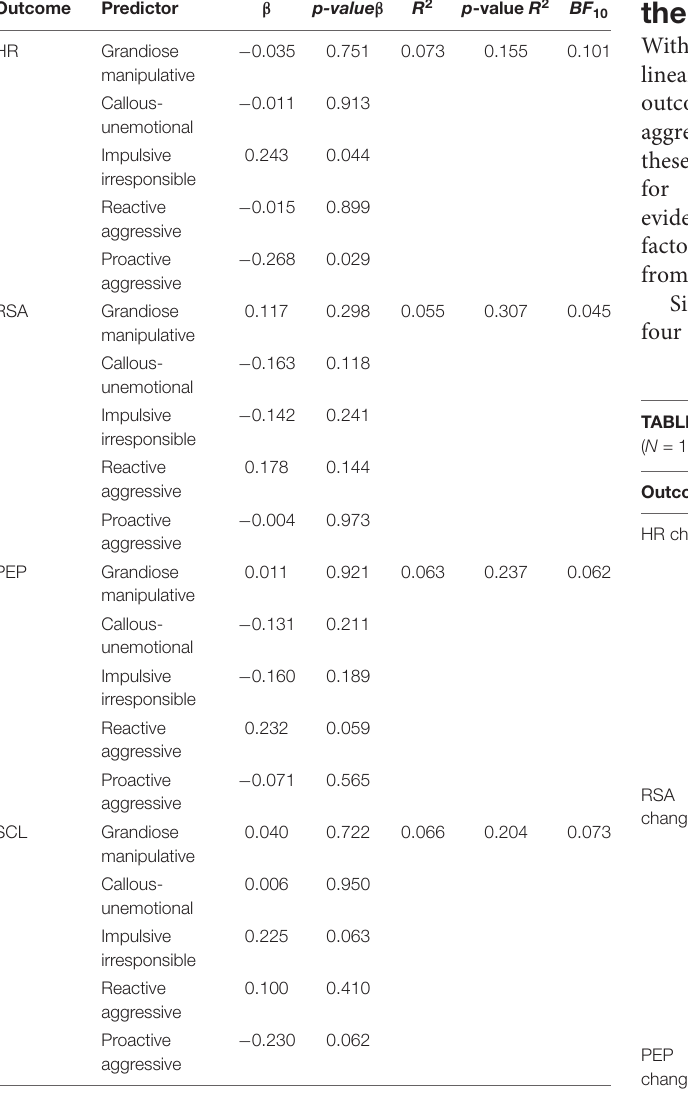
TABLE 3 | ANS baseline regression models within multi-problem young adults ( N = 112). Outcome Predictor β p-value β R 2